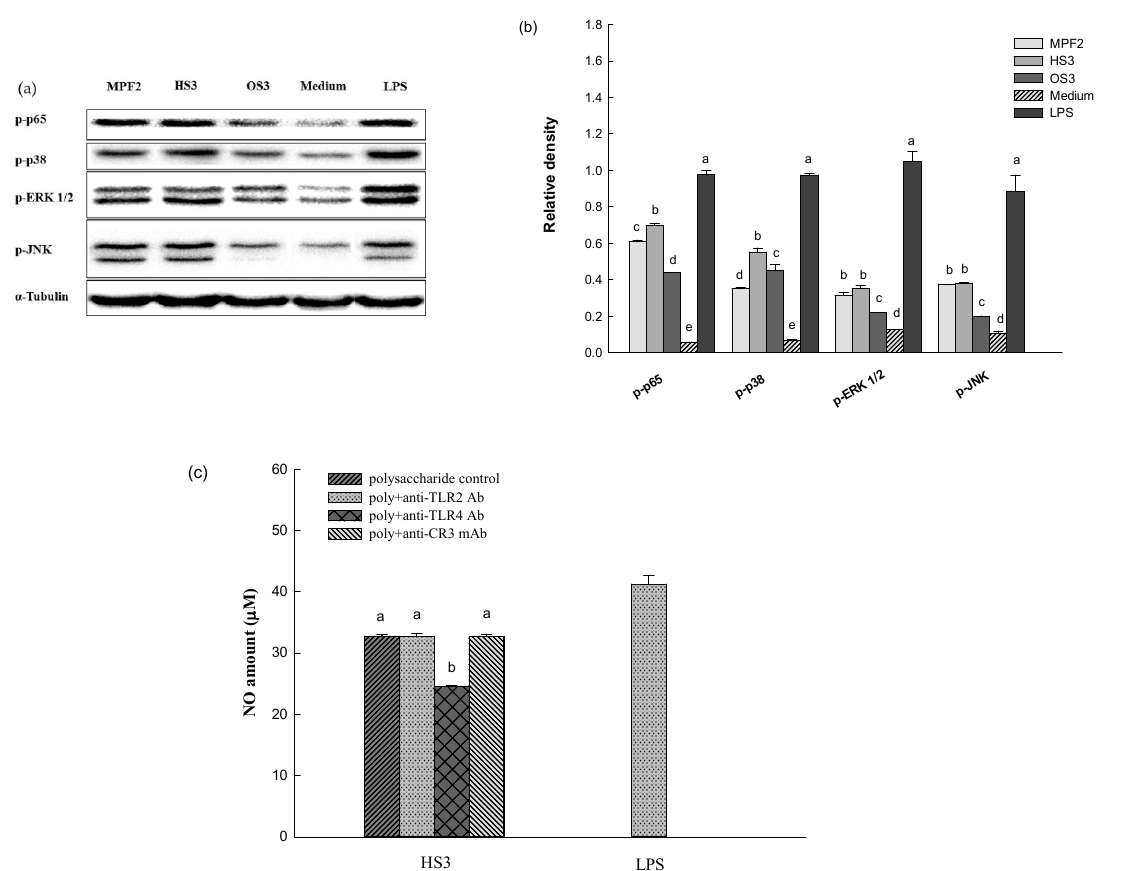
Figure 5. NF-κB and MAPK phosphorylation in RAW264.7 cells: ( a ) the phosphorylation of p65, ERK, P38, and JNK by the treatment of MPF2, HS3, and OS3, ( b ) relative band intensity, ( c ) HS3 on antibody neutralization assay. Different letters indicate significant differences ( p < 0.05) between polysaccharide control (HS3), and HS3 + anti-TLR2 Ab, HS3 + anti-TLR4 Ab, and HS3 + anti-CR3 Ab.